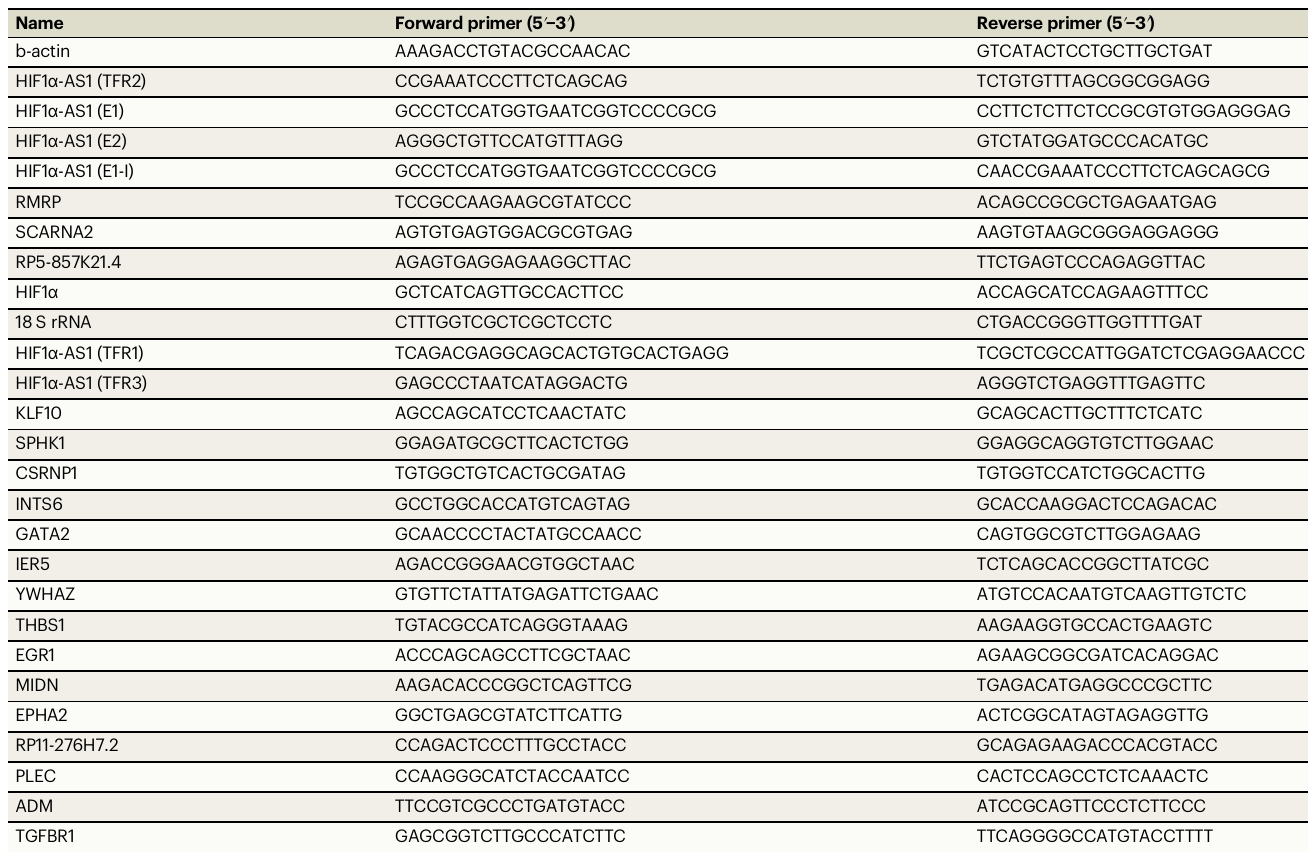
Table 1 | List of primers for